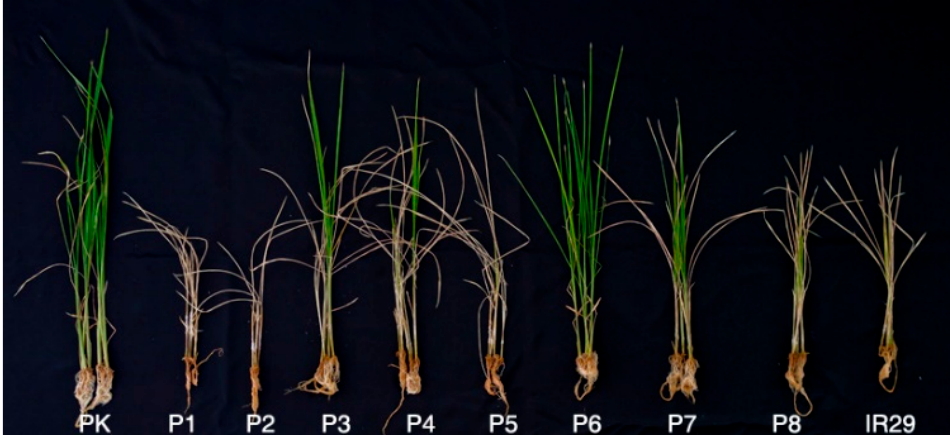
Figure 1. Salt tolerance of the 8 parents by 14 days under 0.7% NaCl stress at the seedling stage. PK: Pokkali (Tolerance check), IR29 (Susceptible check), P1–P8: eight parents.